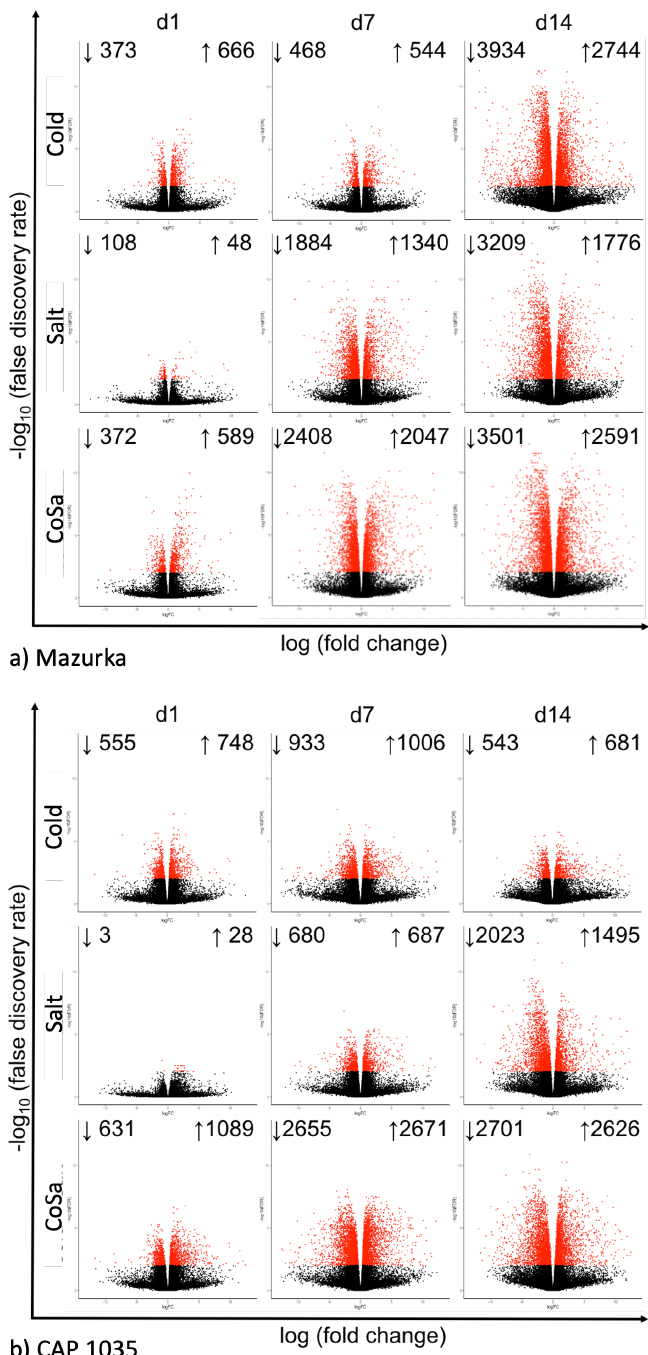
Figure A4. Volcano plots indicating the differentially expressed genes in Mazurka ( a ) and CAP1035 ( b ). Plants were grown under different abiotic stress conditions (chilling temperatures: cold, watering with additional 200mM NaCl (salt), and a combination thereof (CoSa) as indicated) on rockwool. The leaf after first branching was harvested at day 1 (d1), day 7 (d7) and day14 (d14) (as indicated) and a transcriptome analysis was performed comparing the different stress conditions with the control sample from the respective harvest time point. The negative decadic logarithmic values ( − log 10 ) of the false discovery rate are plotted against the logarithmic values of the fold change for each condition in both species. Significantly different expressed genes are highlighted in red, and total numbers are indicated. FDR <